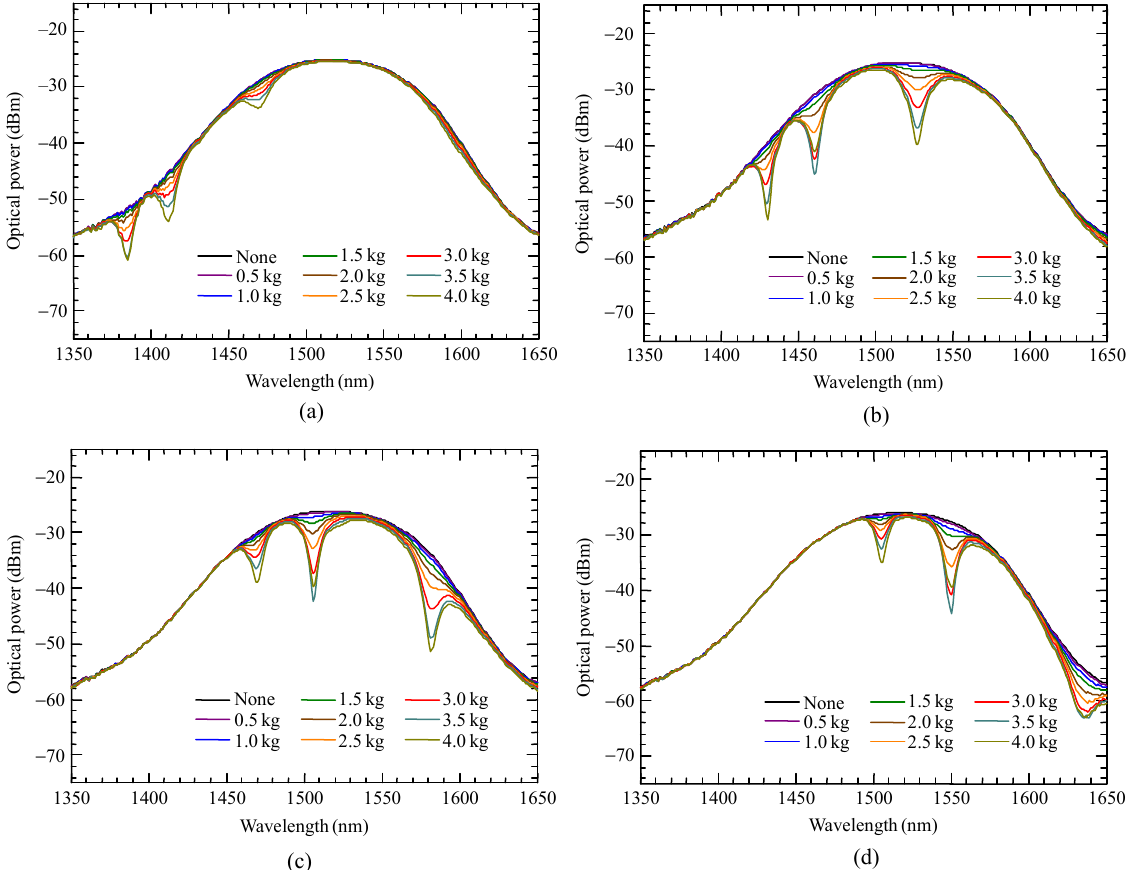
Fig. 4 Resonant wavelengths by the perturbation of 3D printed LPFG device with (a) 520 μ m, (b) 550 μ m, (c) 580 μ m, and (d) 610 μ m grating